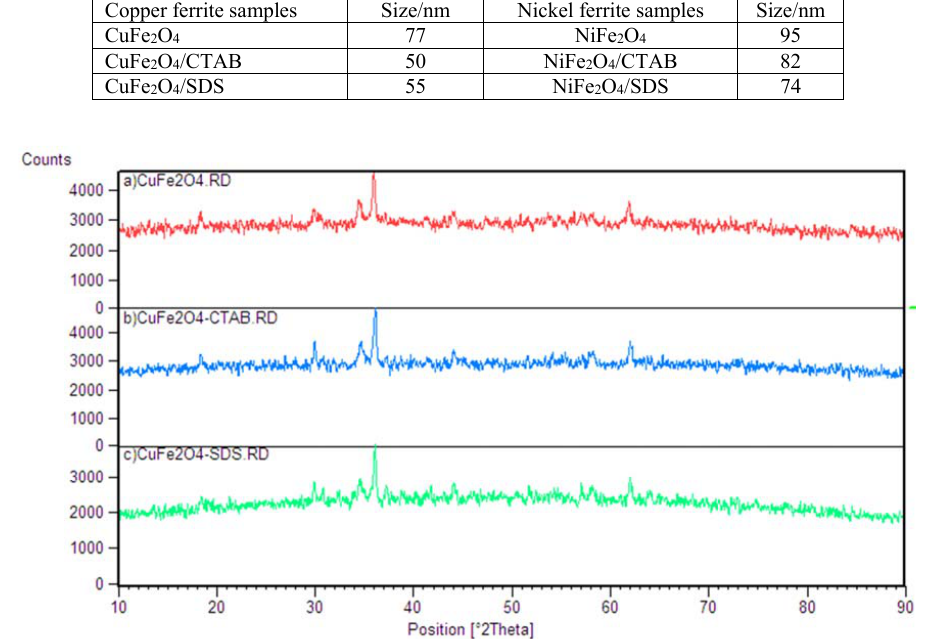
Fig. 1. XRD patterns of CuFe